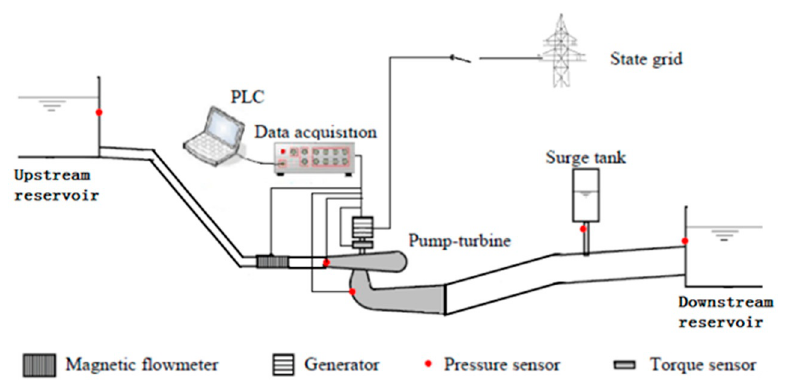
Figure 6. Schematic chart of pressure signal acquisition for single unit load rejection test.